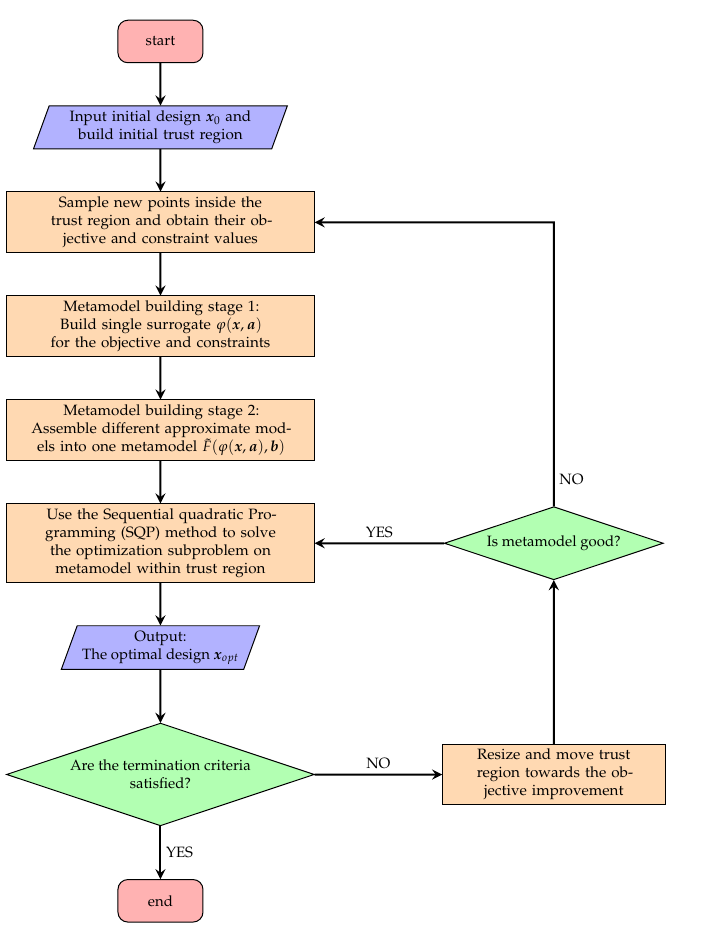
Figure 1. Flow chart of the mulitpoint approximation method